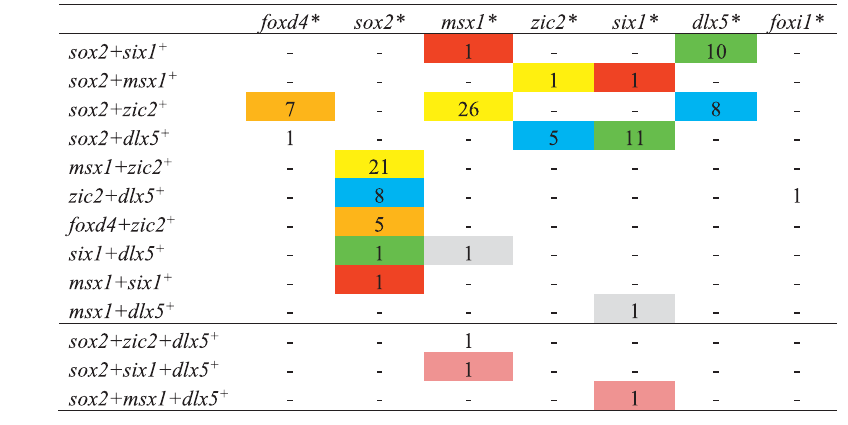
TABLE 4 | The number of single cells co-expressing three or four domain-enriched transcription factors at stage 13.